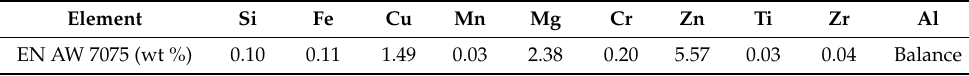
Table 1. Chemical composition of EN AW 7075 alloy determined by OES. Element Si Fe